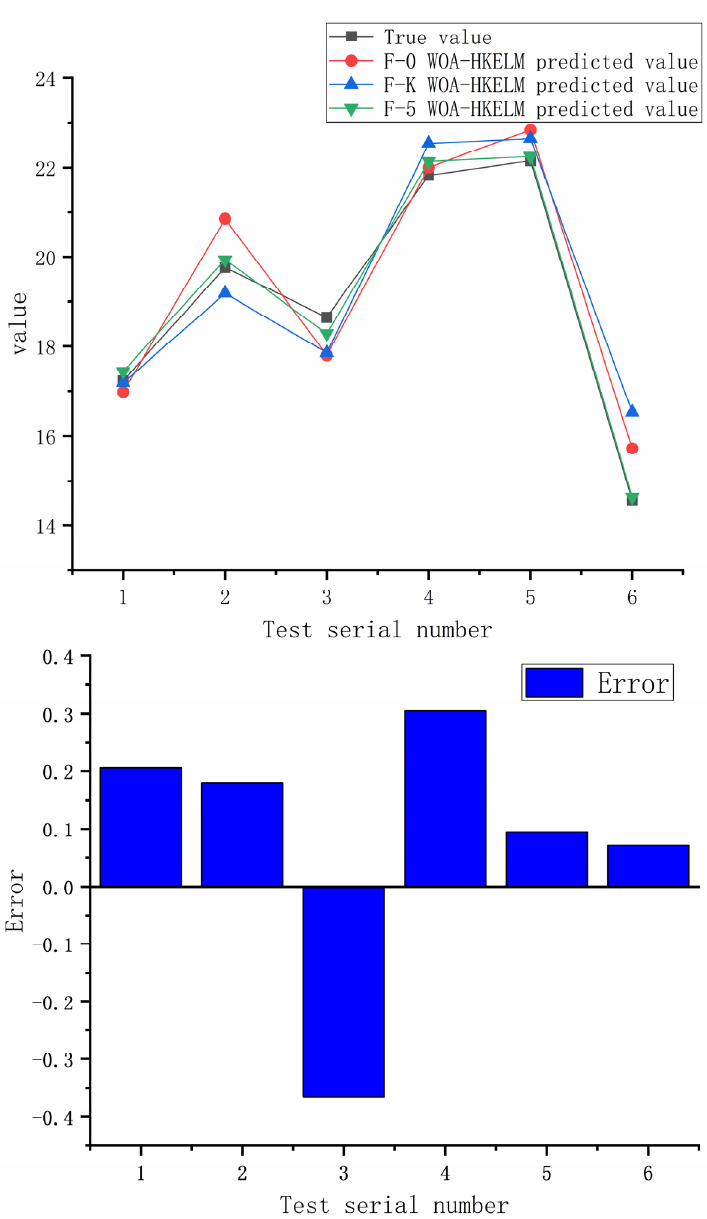
Figure 7. Prediction performance of the best fusion